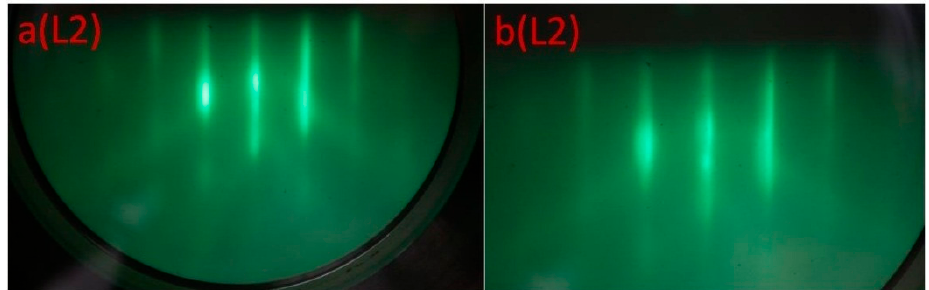
Figure 7. Dose dependences of the RHEED image taken for the L2 region ( a ) after 1 min of irradiation and ( b ) after 5 min of irradiation.